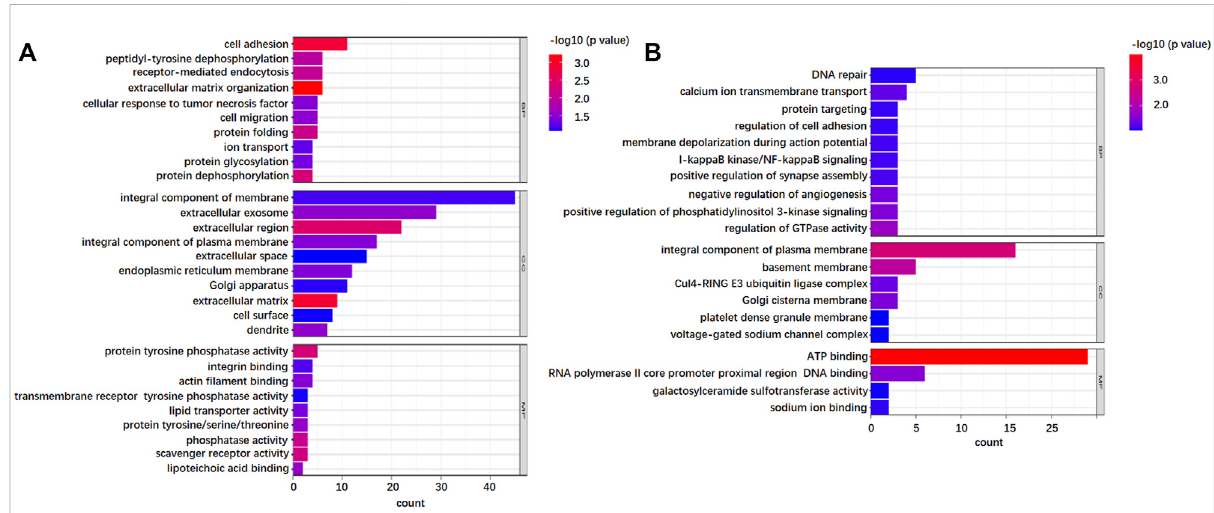
FIGURE 5 Gene Ontology (GO) analysis of the identi fi ed N-glycoproteins from 736 DEPGs. (A) GO enrichment of top 10 biological process (BP), cellular component (CC), and molecular function (MF) terms for 421 upregulations. (B) GO enrichment of top 10 B P, CC, and MF terms for 325 downregulations.